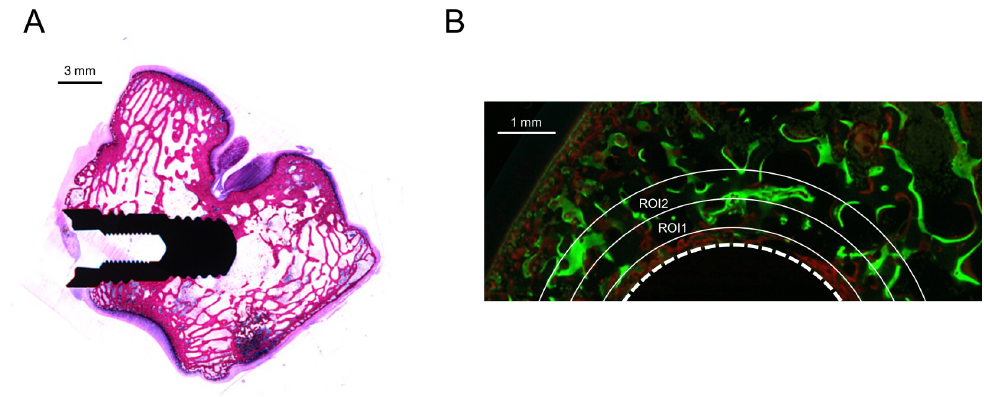
Fig 4. Histological analysis of rabbit femoral condyle implantation model after 8 weeks. Histological section stained with HE shows positioning of screw in medial femoral condyle within the subchondral trabecular bone (A). Incorporation of calcein green (green signal) and alizarine complexone (red signal) fluorescent dyes into newly formed bone at 2 and 4 weeks after implantation, respectively, of a screw coated with 9 μ g testosterone and 2 μ g alendronate (B). Fluorescent signal was observed directly at the surface of the screw (dashed line) but also extending into VOI1 (0.3–0.8 mm from screw) and VOI2 (0.8–1.3 mm from screw).